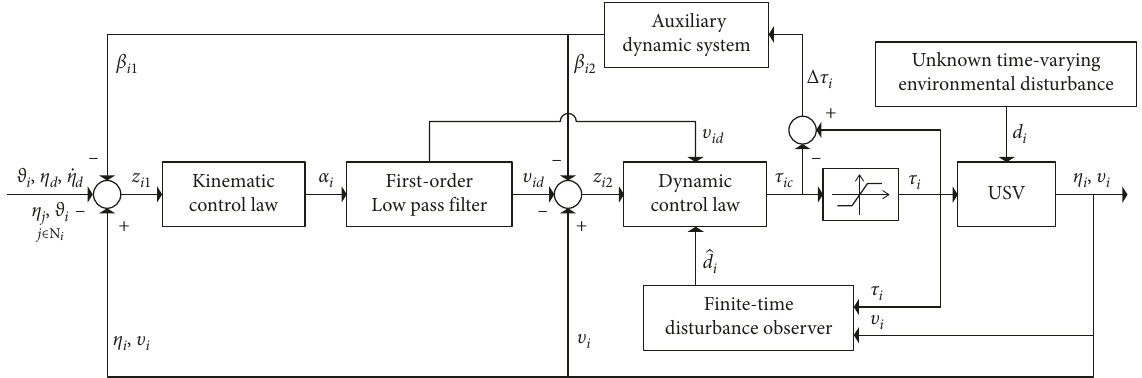
Figure 2: Structure diagram of multiple unmanned surface vehicles swarm